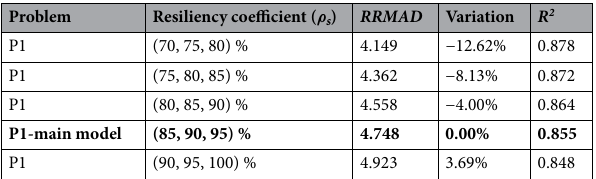
Table 9. Analyzing the resiliency coefficient. Significant values are in bold.